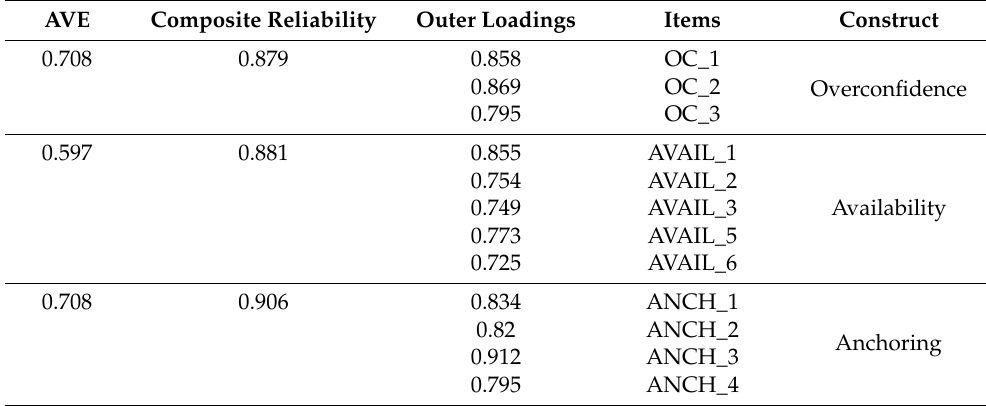
Table 3. Composite Reliability, AVE, and Outer